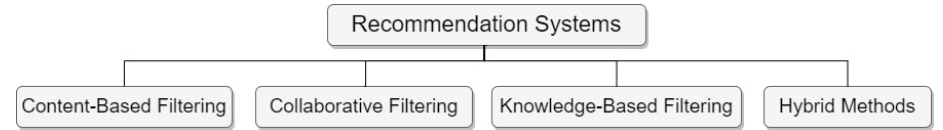
Figure 2. The classi fi cation of recommendations systems.